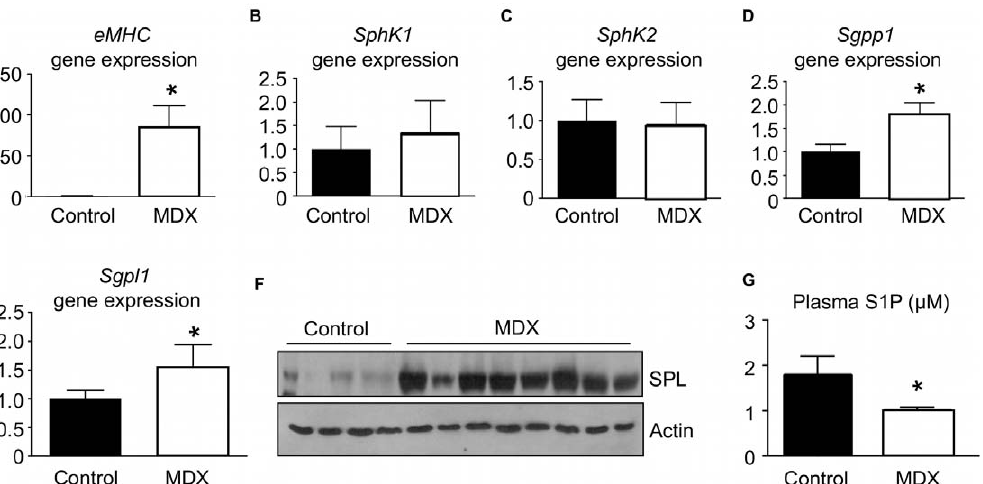
Figure 4. Dystrophic mice are characterized by an S1P-deficient state. Gene expression of eMHC, a marker of regenerating muscle, and key enzymes involved in S1P metabolism were examined by qRT-PCR in C57BL10/J and mdx (C57BL/10J background) mouse muscles under basal conditions. Data are means 6 SD, n=5/group; * indicates P , 0.05. A) eMHC ( Myh3 ) gene expression. B) Sphk1 gene expression. C) Sphk2 gene expression. D) Sgpp1 gene expression. E) Sgpl1 gene expression. F) SPL protein expression. G) Plasma S1P levels. Data are means 6 SD, n=4–5/group for plasma S1P; * indicates p # 0.05. Gene expression levels for qRT-PCR were normalized to GAPDH.